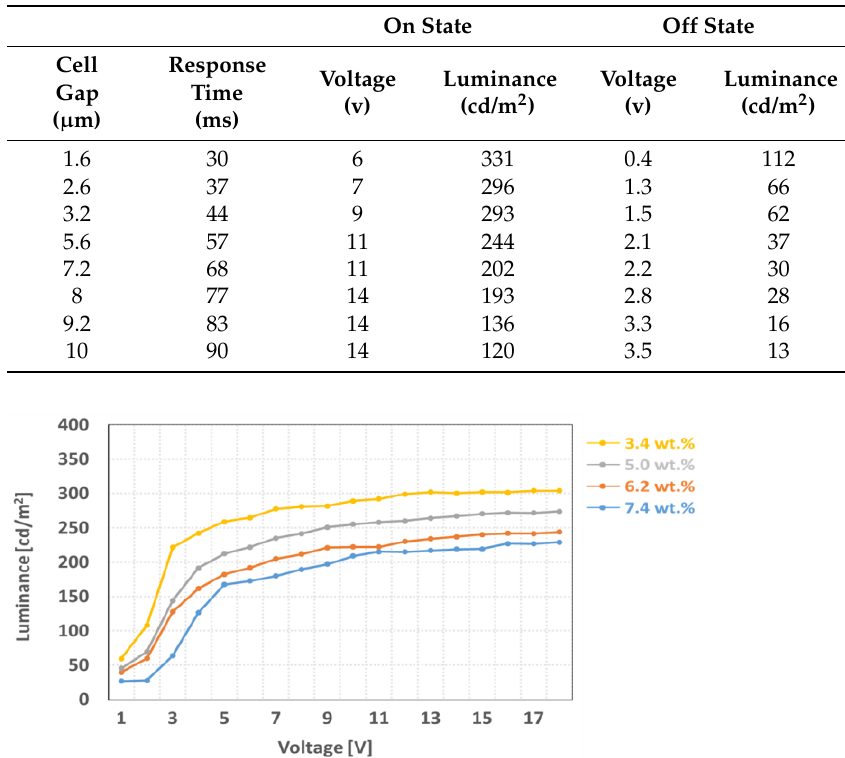
Figure 5. Measured voltage-luminance of the polarized mode LC cell as a parameter of cell gap at 6.2 wt % of the dichroic dye concentration.